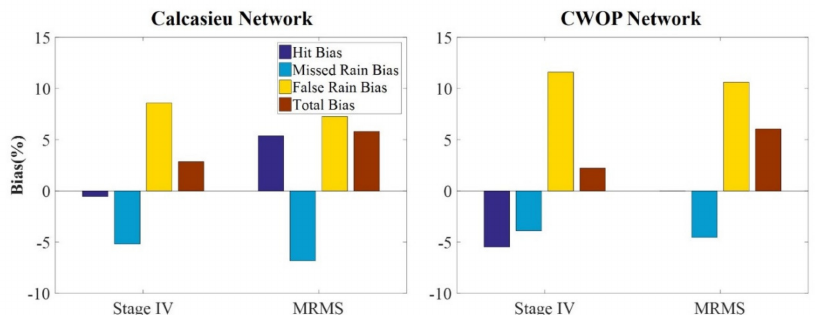
Figure 9. Decomposition of the total bias of radar-rainfall products (Stage IV and MRMS) into three components (hit, missed, and false rain bias) for the Calcasieu and CWOP networks. The decomposed bias components are expressed as percentages of the total rainfall